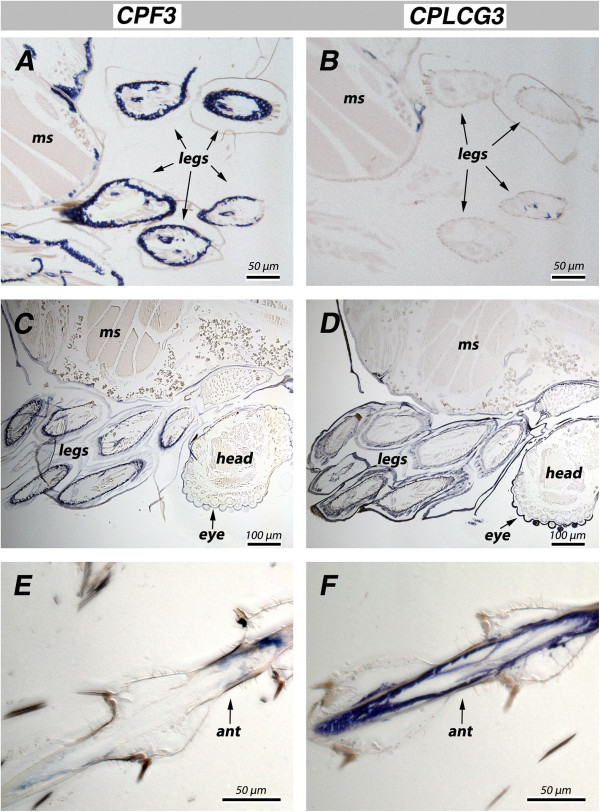
In situ hybridization to appendages of animals of different ages. Most common is greater hybridization for CPF3 than CPLCG3 in P24 (A, B). But occasionally there is similar hybridization of both at P24 (C, D). After eclosion, CPLCG3 is generally stronger in appendages than CPF3, here the antenna of a young adult male, 17–19 h post-eclosion (E, F). ms, muscle; ant, antenna.